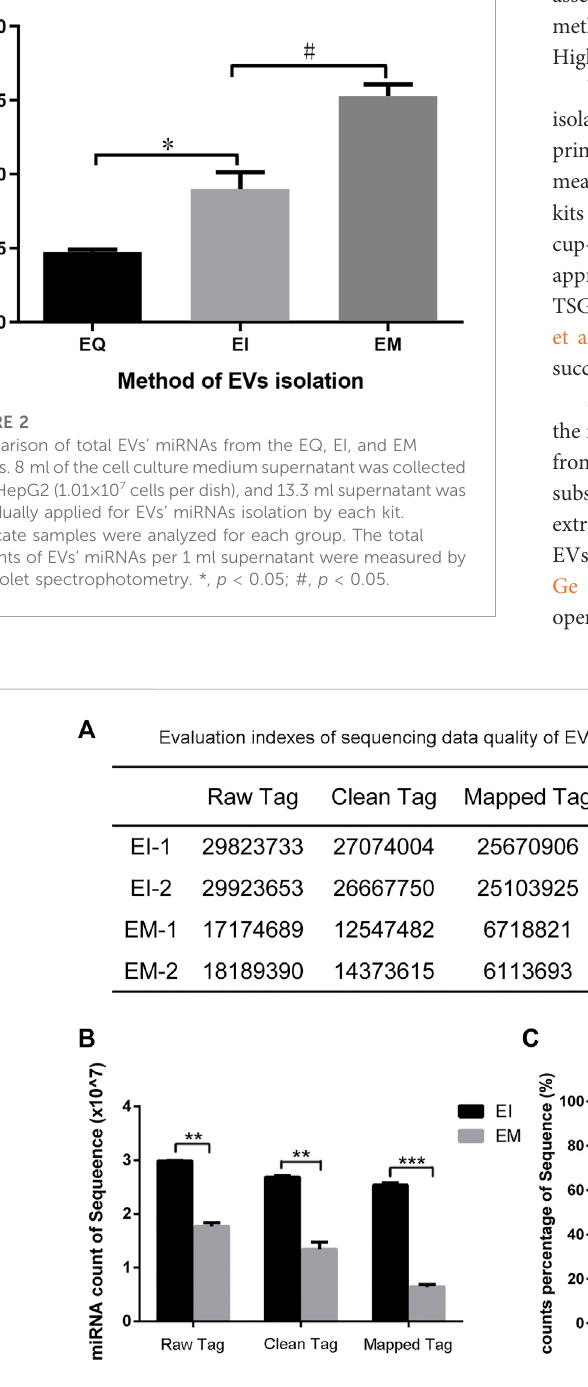
FIGURE 3 Analysis of EVvs ’ miRNAs sequencing data from the EI and EM groups. 8 ml of the cell culture medium supernatant was collected from HepG2 (1.01×10 7 cellsperdish),and13.3 mlsupernatantwasindividuallyappliedforEVs ’ miRNAsisolationbyeachkit.Duplicatedsampleswereanalyzedfor each group. High-throughput sequencing was performed for EVs ’ miRNAs from the EI and EM group. (A) Statistical analysis results of two sets of sequencing data. (B,C) High-throughput sequencing data quality comparison between the two groups. *, p < 0.05, **, p < 0.01, ***, p <